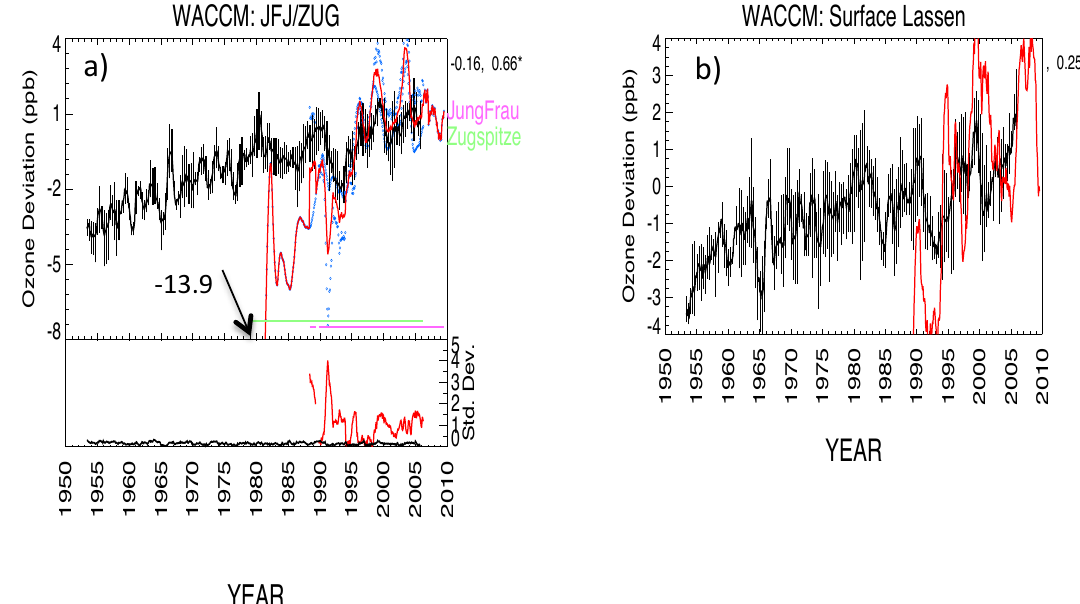
Figure 5. As in Fig. 3 but for the surface simulated and measured ozone deviations (ppb): (a) averaged for the Jungfraujoch and Zugspitze sites; (b) the Lassen site. The bottom bars in (a) indicate the years for which an annually averaged measurement was available at the Jungfraujoch and Zugspitze sites.